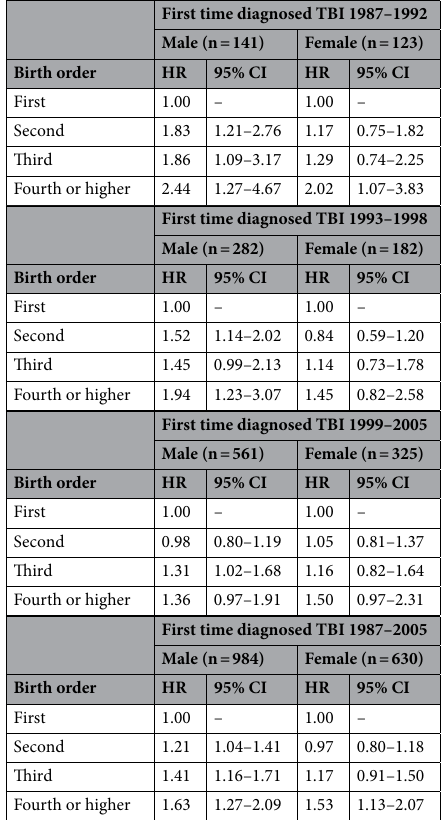
Table 4. Hazard of TBI by birth order and sex in Finland, 1987–2005. Both sexes are adjusted for the joint effect of sex and birth order, as well as the main effects of sex and maternal age at child’s birth.